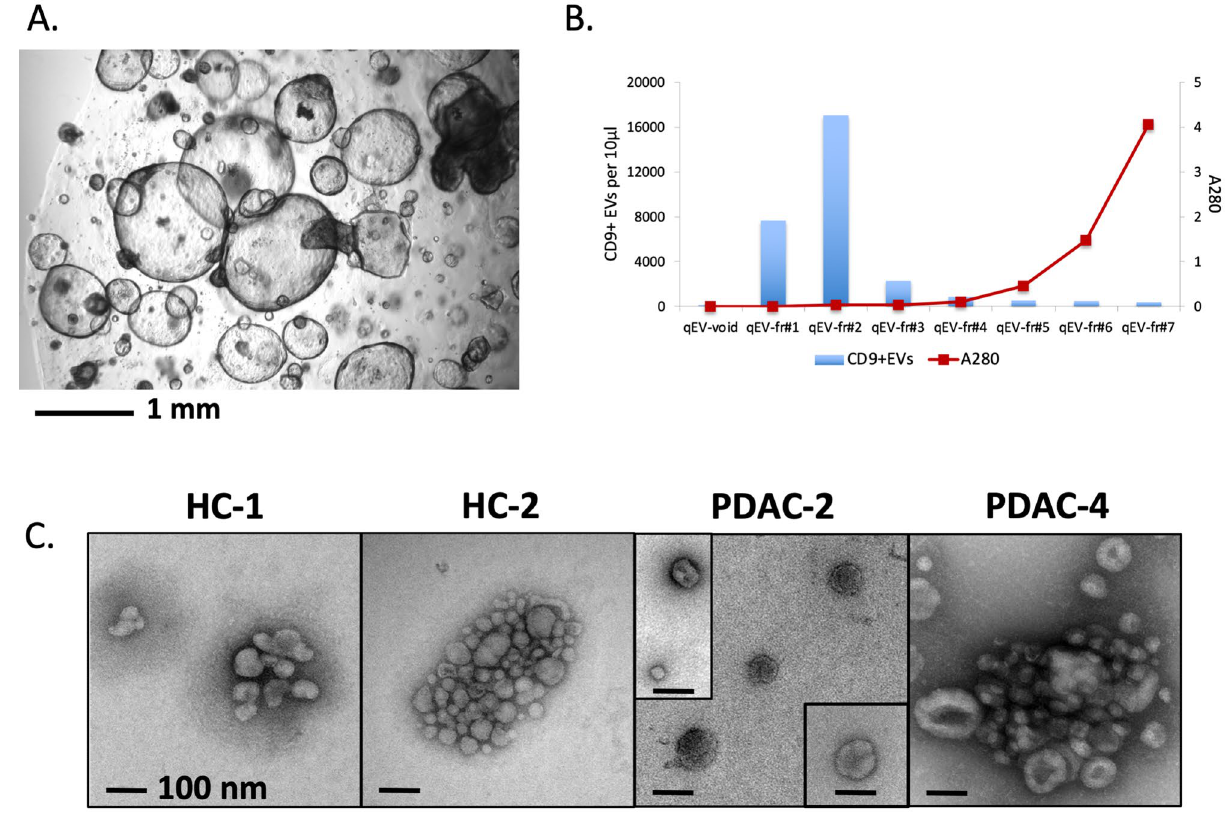
Figure 2. Isolation of EVs from organoids established from PDAC patients and healthy controls (HC). ( A ) Image of representative pancreatic organoid culture (PDAC). ( B ) Fractions obtained after size exclusion chromatography (SEC) of PDAC organoid supernatants were analyzed for CD9 + EVs by flow cytometry and protein levels by measurement at 280 nm. ( C ) Representative EM images of EVs isolated after SEC on supernatants collected from two healthy control (HC-1 and HC-2) and two PDAC (PDAC-2 and PDAC-4) organoid